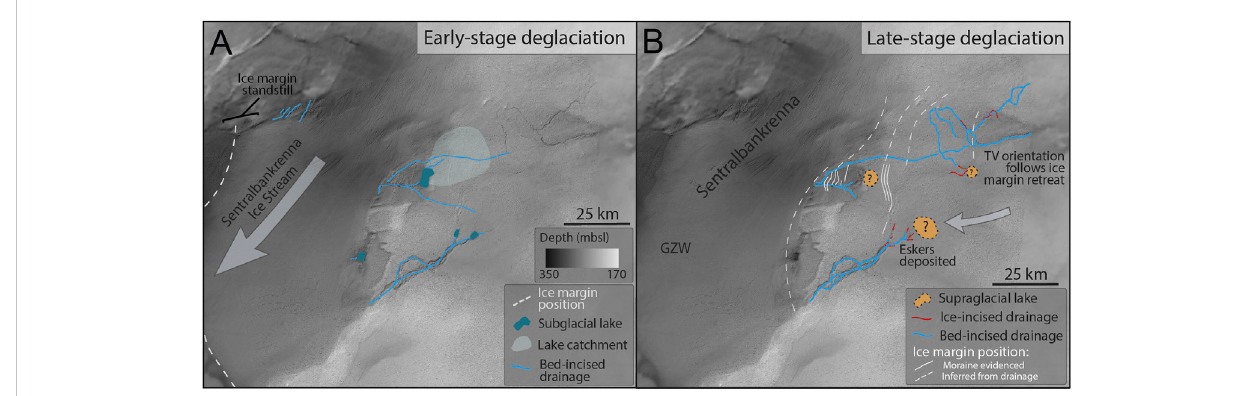
FIGURE 11 Reconstruction of subglacial meltwater drainage during deglaciation (A) Early-stage deglaciation while icewas still fl owing in Sentralbankrenna and (B) towards the later stages of deglaciation and ice retreat over Thor Iversen-banken. Substrate-incised channels in the north-west are included from previously published mapping of meltwater channels and tunnel valleys (Bjarnadóttir et al., 2017; Esteves et al., 2017). A conservative catchment for the interlinked basins is estimated to provide lake fi ll rates (Supplementary Figure 1). GZW=Grounding Zone